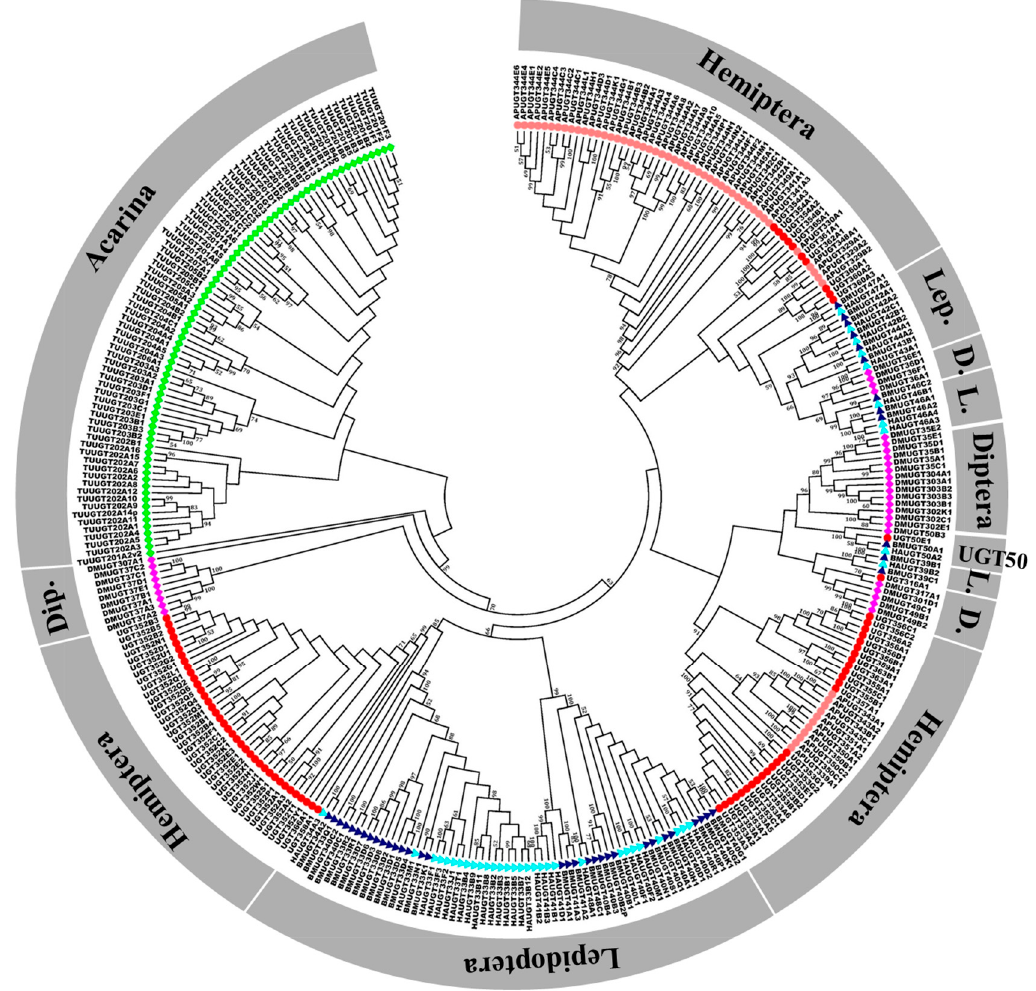
Figure 3. Phylogenetic relationships among UDP-glucuronosyltransferases (UGTs) in B. tabaci MEAM1 and other organisms. The amino acid sequences of full-length UGTs were aligned using ClustalW and subjected to a neighbor-joining (NJ) analysis by MEGA6 [42]. Numbers at the branch points of the nodes represent the values resulting from 1000 replications. Hemiptera: The dark red represents Bemisia tabaci , light red represents Acyrthosiphon pisum (Ap); Lepidoptera: the dark blue represents Bombyx mori (Bm), light blue represents Helicoverpa armigera (Ha); Diptera: the pink represents Drosophila melanogaster (Dm); Arachnoidea: the green represents Tetranychus urticae (Tu).